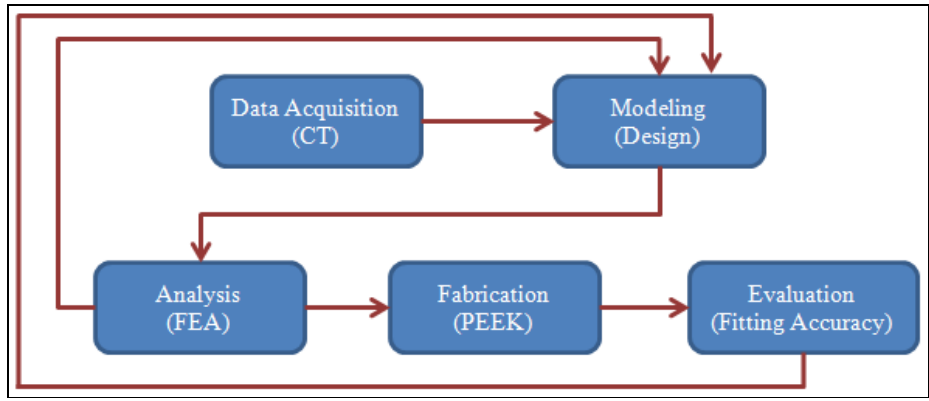
Figure 1. Deriving a cranial implant using a hybrid